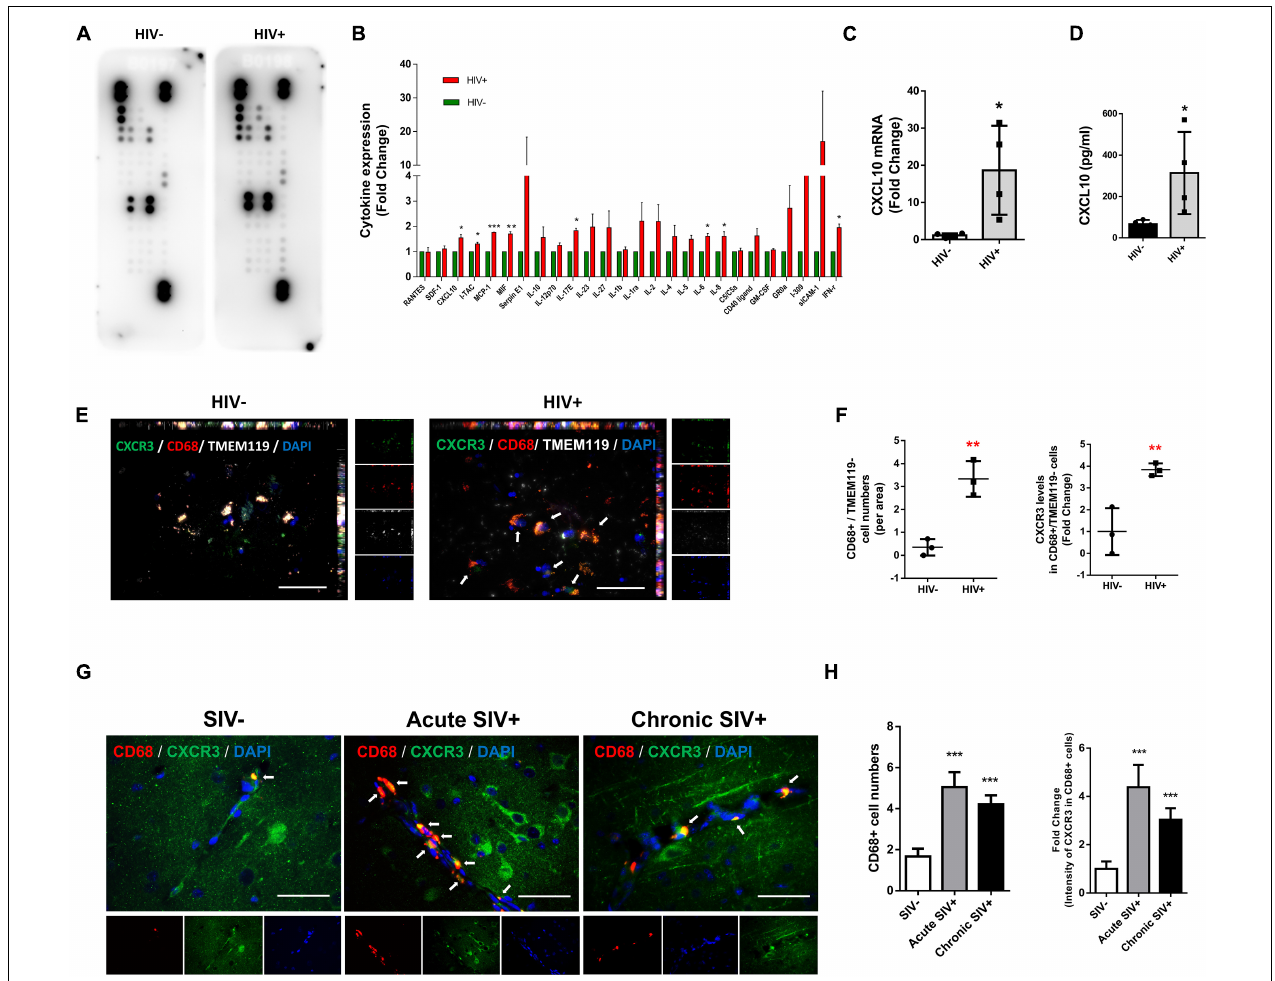
FIGURE 1 | HIV/SIV infection upregulates CXCL10/CXCR3 axis and enhances macrophage infiltration in the brain. (A) Representative dot plots of Proteome Profiler Human Cytokine Array detecting the expression 26 cytokines/chemokines in the brain lysates of controls and HIV+ subjects. N = 3. (B) Quantification of cytokines/chemokines expression levels. (C) Real-time PCR analysis of CXCL10 mRNA expression in the brain lysates of controls and HIV+ subjects. N = 4. (D) ELISA analysis of CXCL10 protein expression levels in the brain lysates of controls and HIV+ subjects. N = 4. (E) Representative immunostaining of the frontal cortices of HIV-/HIV+ infected human ( N = 3) stained with anti-CXCR3 (Green), anti-CD68 (macrophage marker, Red) and anti-TMEM119 (resident microglial marker, white) antibodies. Scale bar = 20 µ m. Arrow: CXCR3+/CD68+/TMEM119– cells. (F) Quantification of CD68+/TMEM119– cells numbers and CXCR3 expression in CD68+/TMEM119– cells in the frontal cortices of HIV–/HIV+ infected human. Four or five images were analyzed per individual. Average values per individual were used for the statistical analysis by Student’s t -test. (G) Representative immunostaining of the frontal cortices of SIV–/acute SIV+/chronic SIV+ infected macaques stained with anti-CD68 (macrophage marker, Red) and anti-CXCR3 (Green) antibodies. Scale bar = 20 µ m. Arrow: CD68+/CXCR3+ cells. (H) Quantification of number of CD68+ cells and CXCR3 expression levels in CD68+ cells in the frontal cortices of SIV-/acute SIV+/chronic SIV+ macaques. Four or five images were analyzed per animal. All data are presented as mean ± SD of four individual experiments (Biological replicates). * p < 0.05 versus HIV- group, ** p < 0.01 versus HIV- group, *** p < 0.001 versus HIV– or SIV– group.